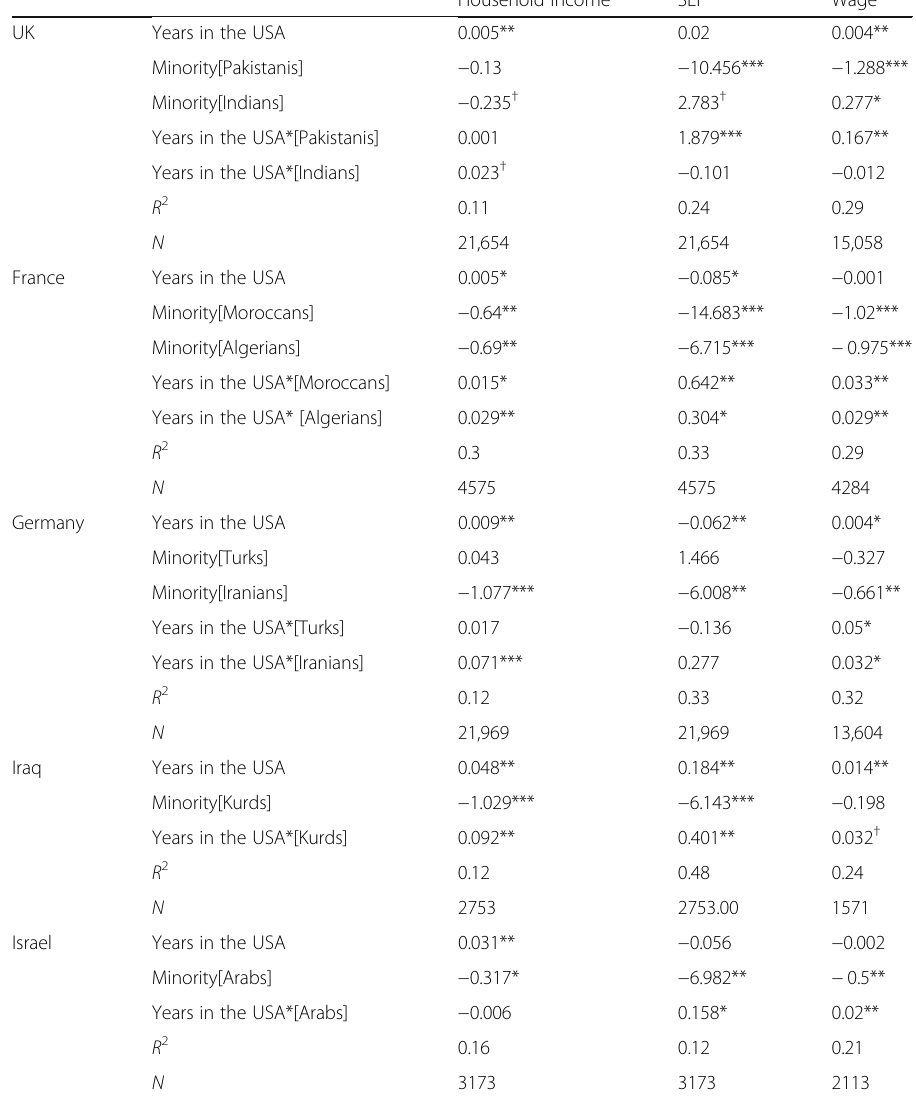
Table 3 OLS regressions of economic characteristics for immigrants to the USA, age 25 to 64, interaction of ethnicity with years in the